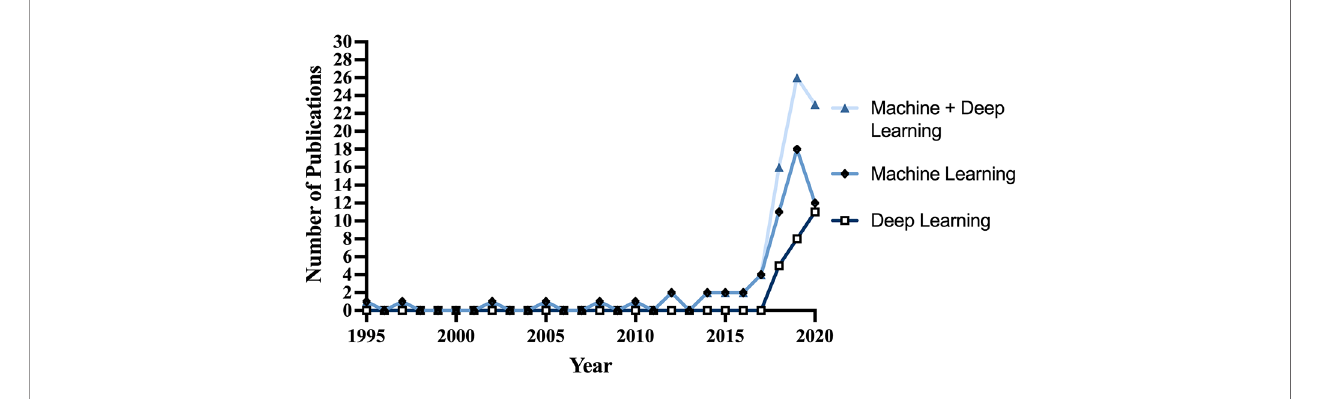
FIGURE 2 | Number of studies published per year from 1995-2020.